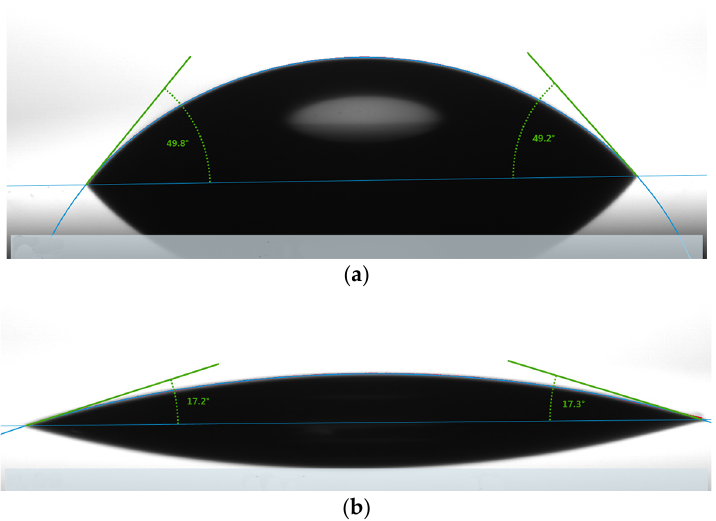
Figure 1. ( a ) The contact angle of as-received wafer; ( b ) The contact angle with the wet chemical activation process.